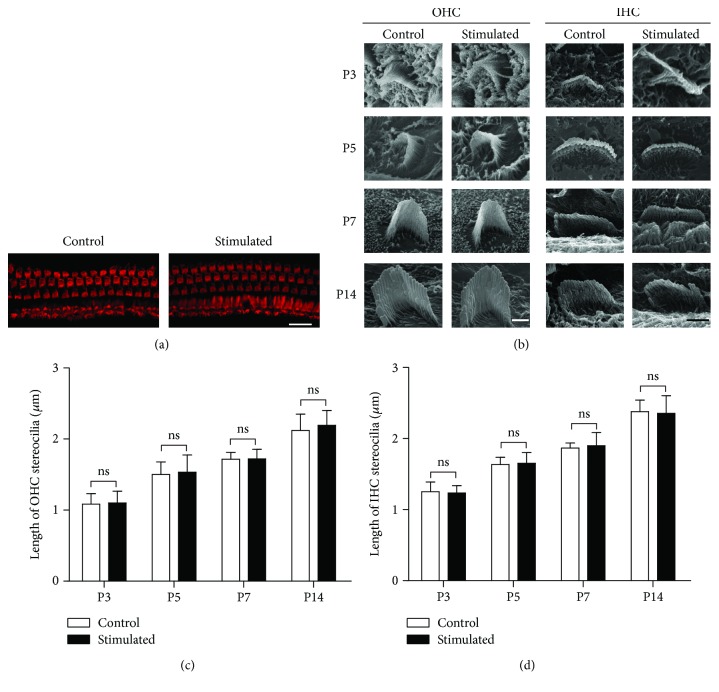
Low-frequency sound environment did not change the alignment and the growth of hair bundles in hair cells in the apical turn of the cochleae. (a) Three rows of OHCs and one row of IHCs (labeled with rhodamine-phalloidin (red)) were observed in both acoustic-stimulated and control groups at P14. Scale bar = 20 μm. (b) Scanning electron microscope images of the hair bundles of OHCs and IHCs in the apical turns of the cochleae at different postnatal ages. Scale bar = 1 μm for OHCs. Scale bar = 2 μm for IHCs. (c) and (d) depict the length of OHC (c) and IHC (d) stereocilia at different postnatal ages. At least six cells from six cochleae were measured for each column. All data points represent as mean ± standard deviation. INC: inner hair cell; ns: no significance; OHC: outer hair cell; P: postnatal day.